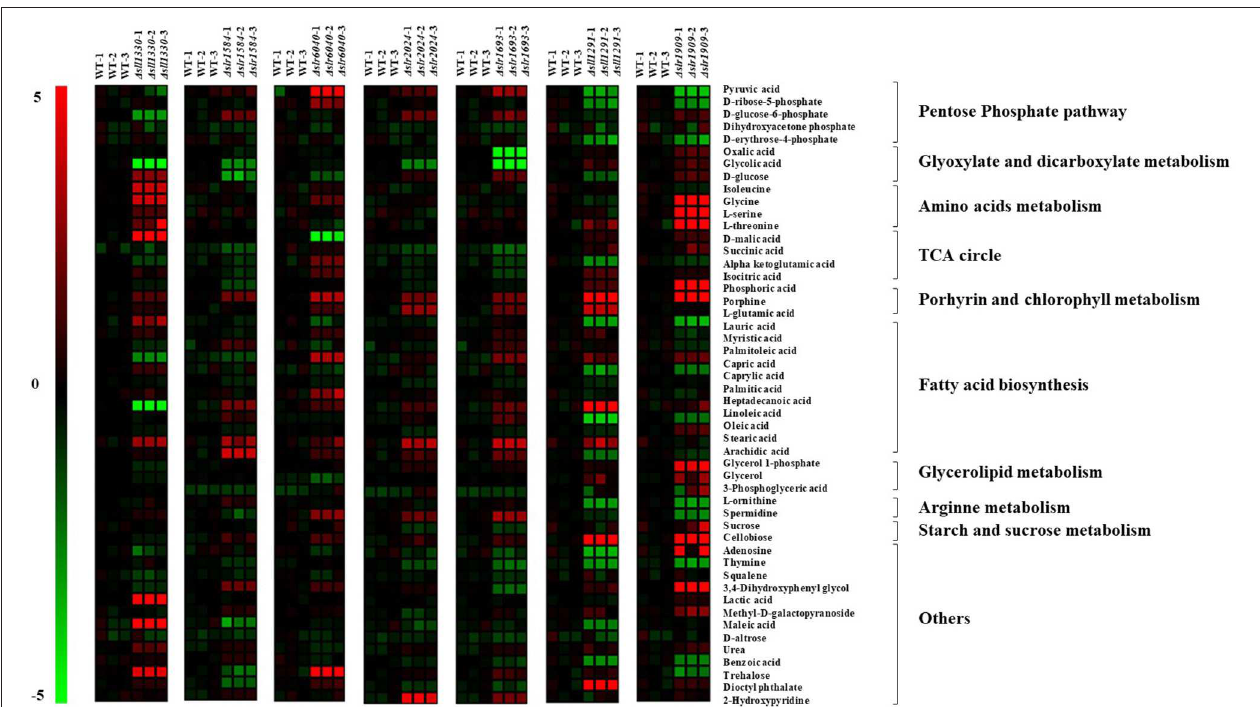
FIGURE 4 | Heat map presentation of the metabolomic changes in 7 most regulated mutants compared with the wild